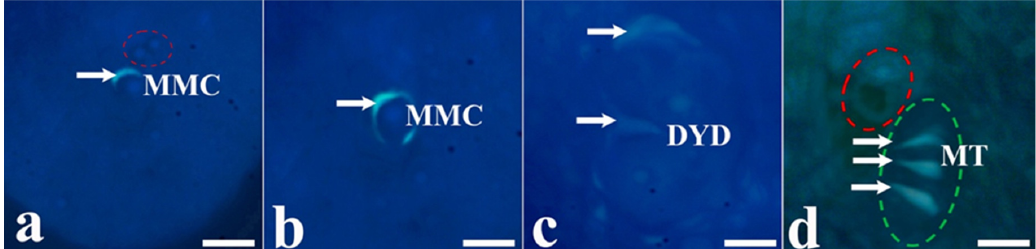
aposporic initial cell (into the red circle), b Megaspore mother cell surrounded by callose (arrow), c Callose accumulation (arrow) on the transverse wall of dyad cell, d Callose accumulation (arrows) on the transverse wall separating each of the tetrad cells (into the green circle) and no callose accumulation around the vacuolated aposporic initial cell (into the red circle). MMC: Megaspore mother cell, DYD: Dyad cells, MT: Megaspore tetrad. Bar: 10